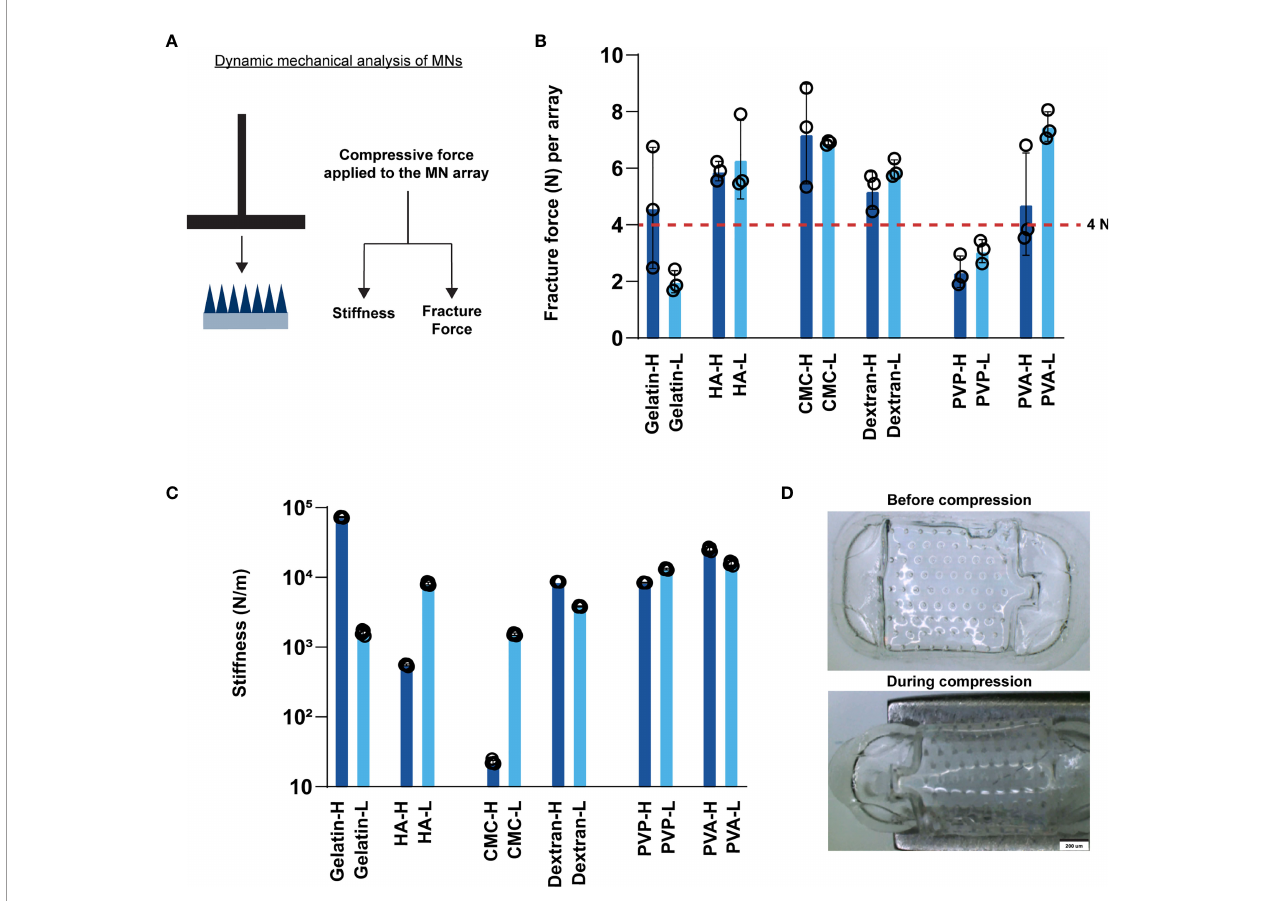
FIGURE 2 | MNs exhibit varying stiffness and fracture forces as a function of matrix type. (A) Schematic showing the experimental setup for measuring fracture force and stiffness. (B) Fracture force of the fabricated MN arrays. The red horizontal line at 4N indicates the minimum force required to penetrate the skin per array. (C) Stiffness of the fabricated MNs. (D) Images of high MW CMC MNs before and during